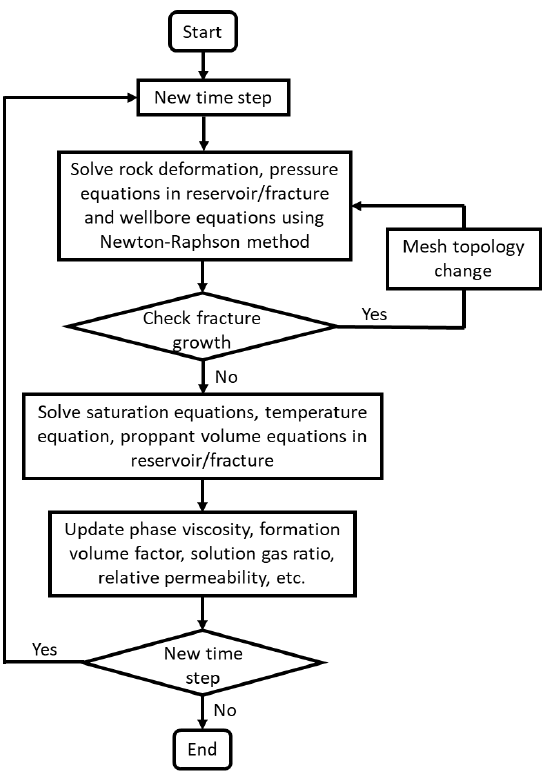
Figure 4. Simulator solution algorithm (Implicit pressure, explicit concentration).